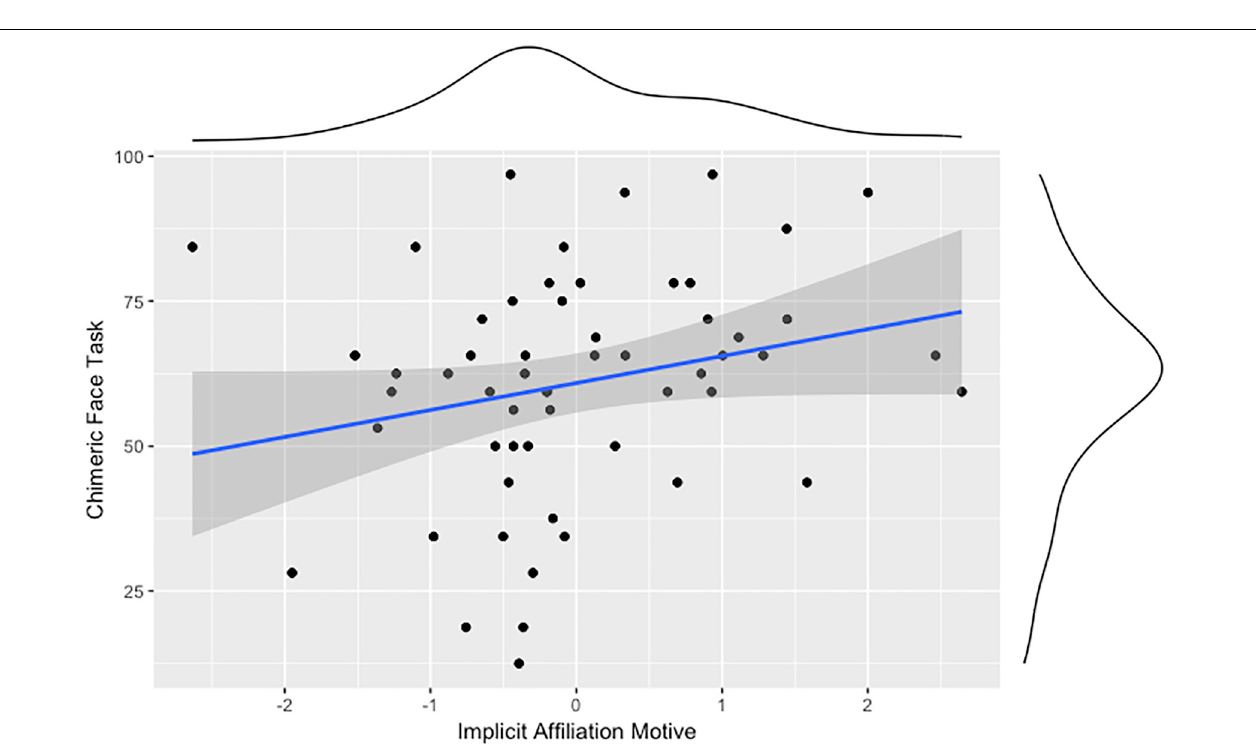
Frontiers in Psychology |